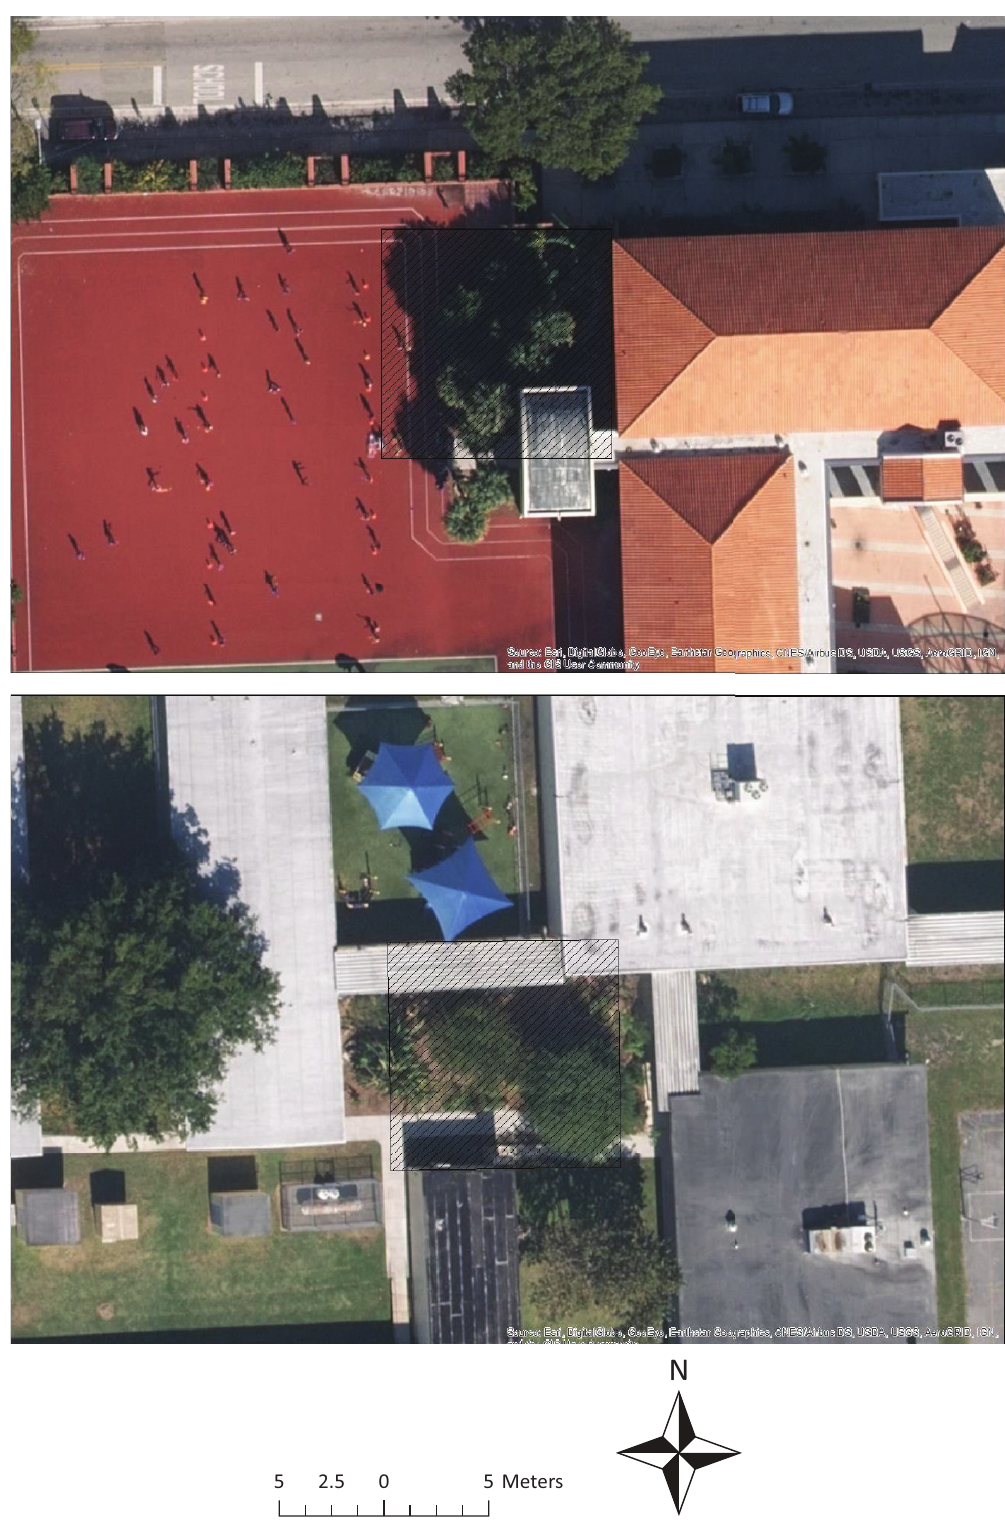
Figure 3. 20 × 20 m plots located in FF gardens at two of the participating Miami‐Dade County Public Schools. (Figure 4). Points were categorized as “tree” or “non‐ tree.” For the purpose of this study, tall herbaceous plants (e.g., papaya and banana) were also included under the “tree” category, given their height, which was